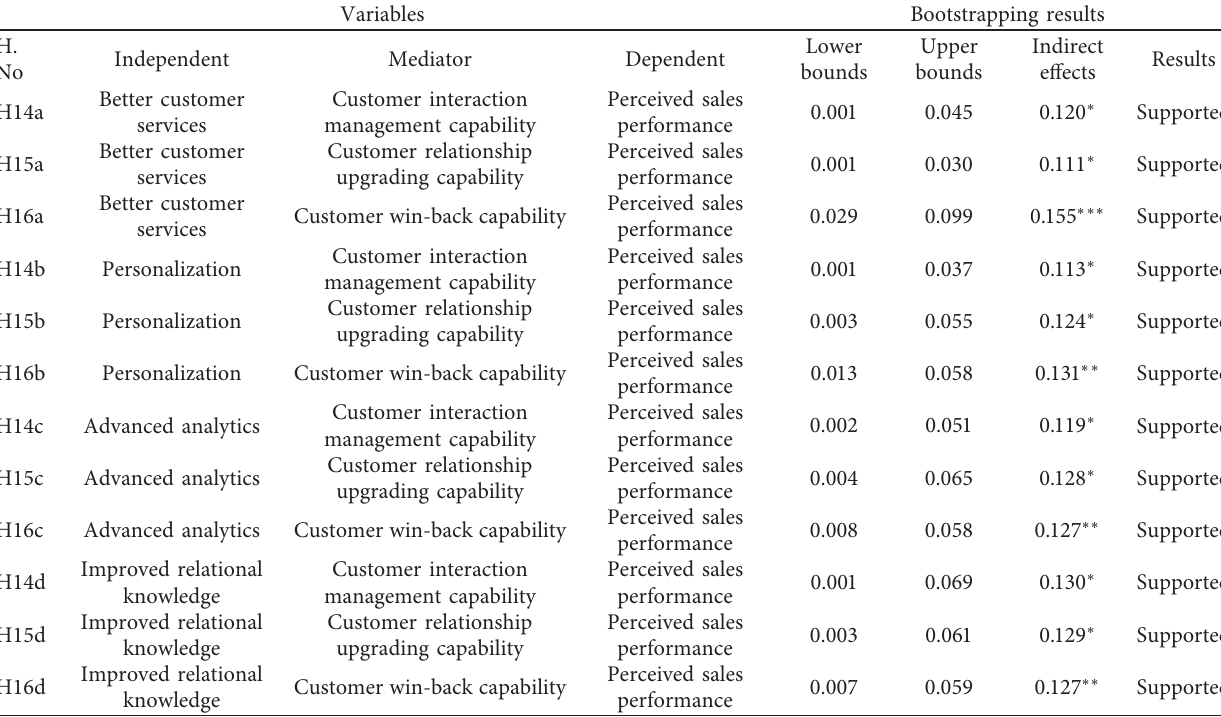
Figure 2: SEM results of research model. Table 7: Bootstrapping results to measure the specific indirect